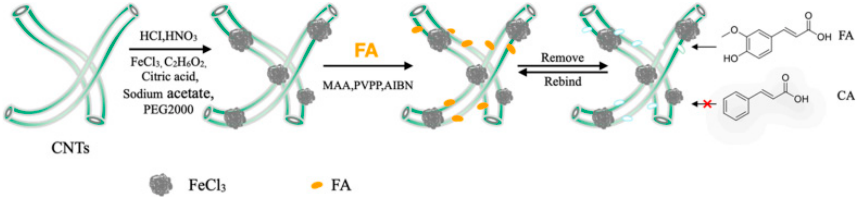
Figure 8. The synthesis procedure of MCNTs@FA-MIPs